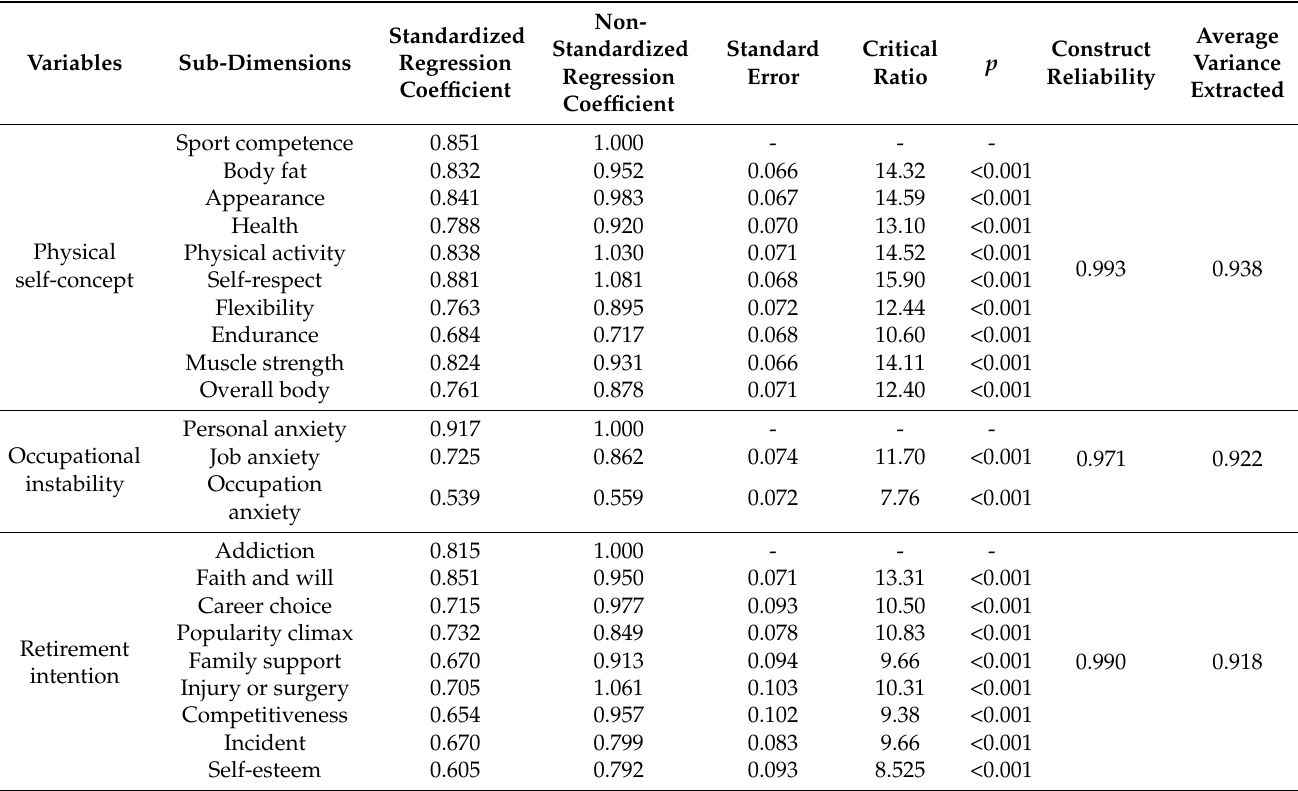
Table 4. Confirmatory factor analysis